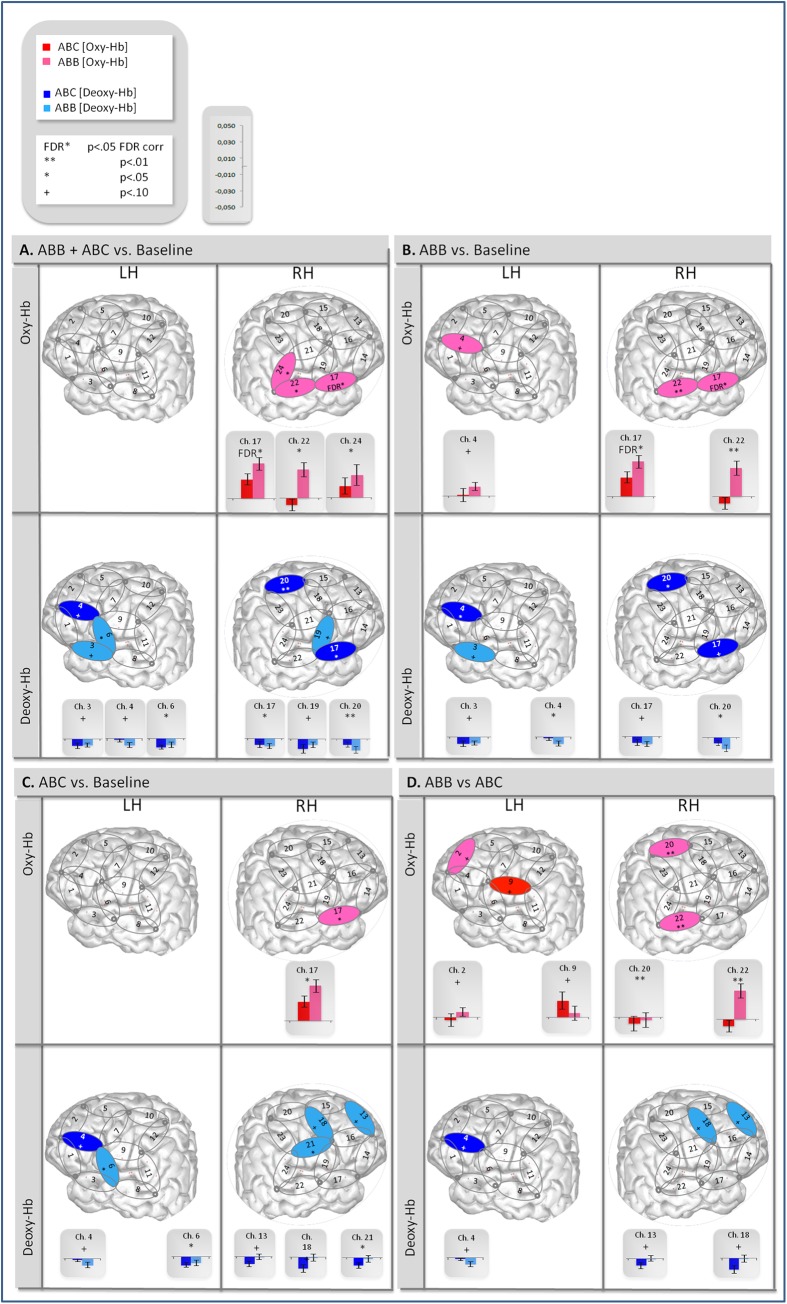
Schematic infant brain and bar graphs of oxyHb and deoxyHb concentrations (in mM.mm) for channels yielding significant t-test comparing responses to: ABB+ABC vs. baseline, (B) ABB vs. baseline, (C) ABC vs. baseline, (D) ABB vs. ABC.Significance levels for t-tests are indicated for each channel by p-values: ‘+’ marginally significant without correction for multiple comparisons;’**’ p < .01 significant without correction; ‘*’ p < .05 significant without correction; ‘FDR’ p < .05 significant after correction for multiple comparisons using the False Discovery Rate (FDR) [52], calculated using the FDR online calculator (http://sdmproject.com/utilities/?show=FDR). The FDR method is typically recommended to correct for multiple comparisons, such as multiple t-test analysis. Given a set of p-values, the FDR method returns p-values adjusted, controlling for the false discovery rate, i.e. the expected proportion of false discoveries amongst the rejected hypotheses.